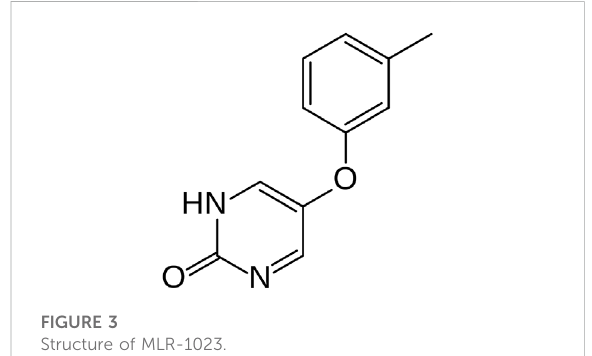
FIGURE 3 Structure of